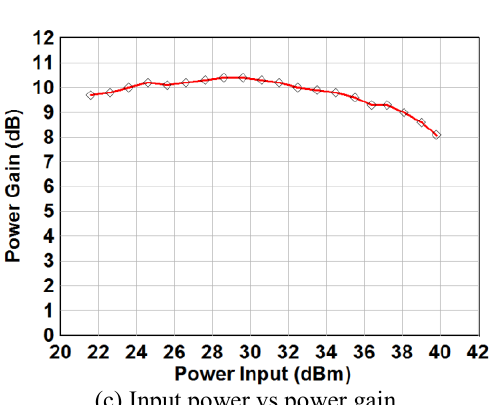
Figure 3: Measured results of the 50 W GaN